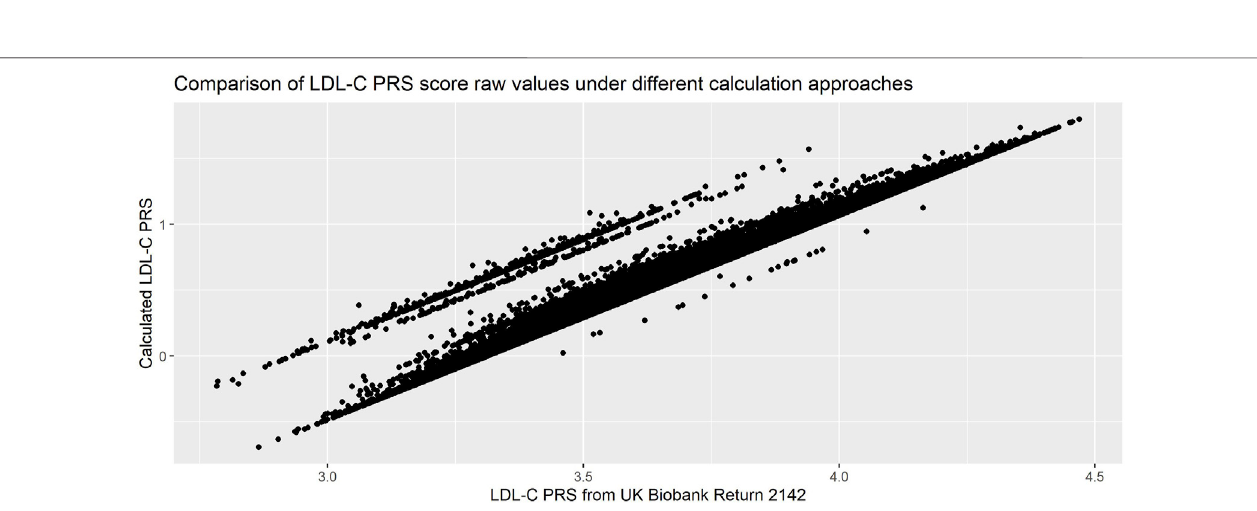
FIGURE7| ComparisonofPRScalculatedusingallelicandhard-calldosages(Pearson ’ scorrelationcoef fi cient=0.99).PRSusedwas223-SNPscorefrom(Klarin et al., 2018), with hard-called dosage approach from (Trinder et al., 2020b).